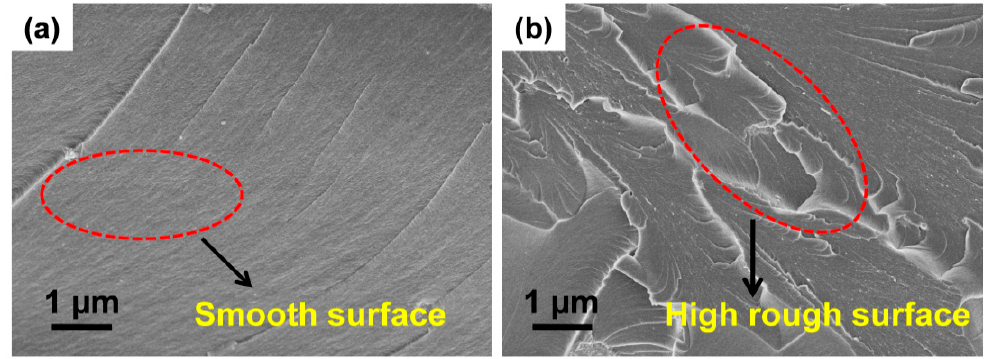
Figure 7. FESEM images of the fractured surface of tensile strength-tested 3D-printed samples: ( a ) neat SLR and ( b ) R/ANT800.